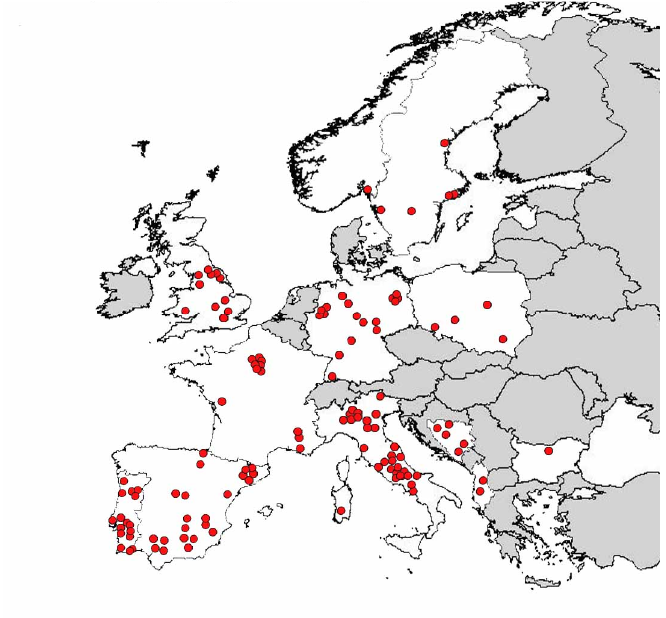
Source: Sintomer et al.,